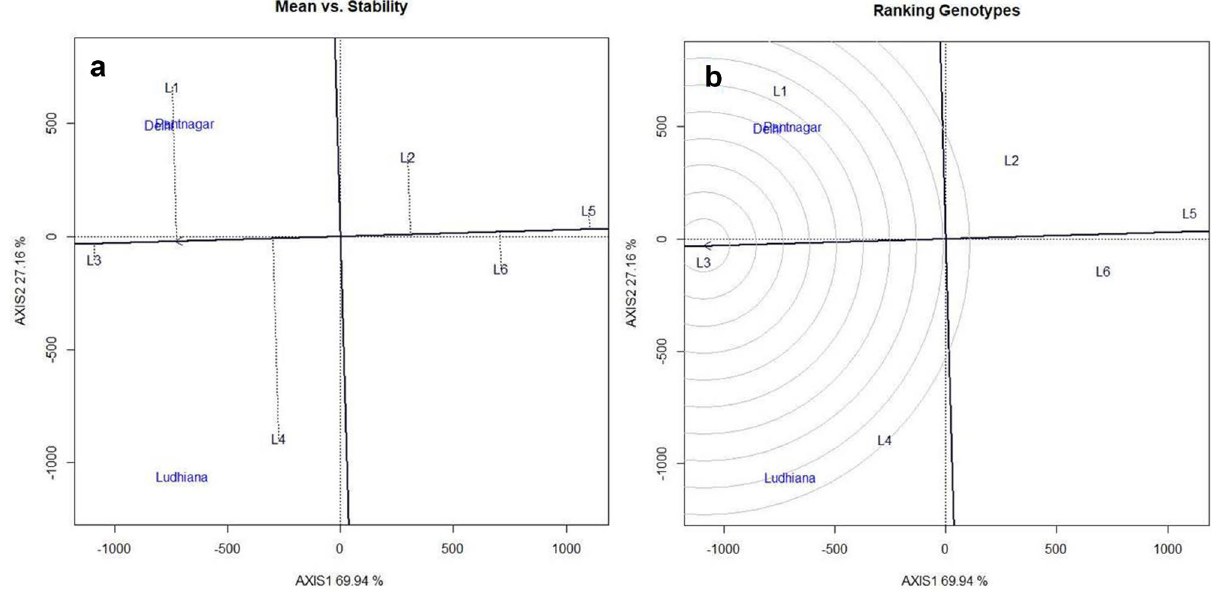
Figure 6. GGE Biplot analysis of genotypes evaluated in Northern Plain Zone: ( a ) Mean vs Stability analysis, ( b ) Ranking of genotypes based on ideal genotype: L1-PS 1613, L2-PS 1611, L3- NRC 128, L4- PS 1347, L5-Pusa 97–12 and L6-SL